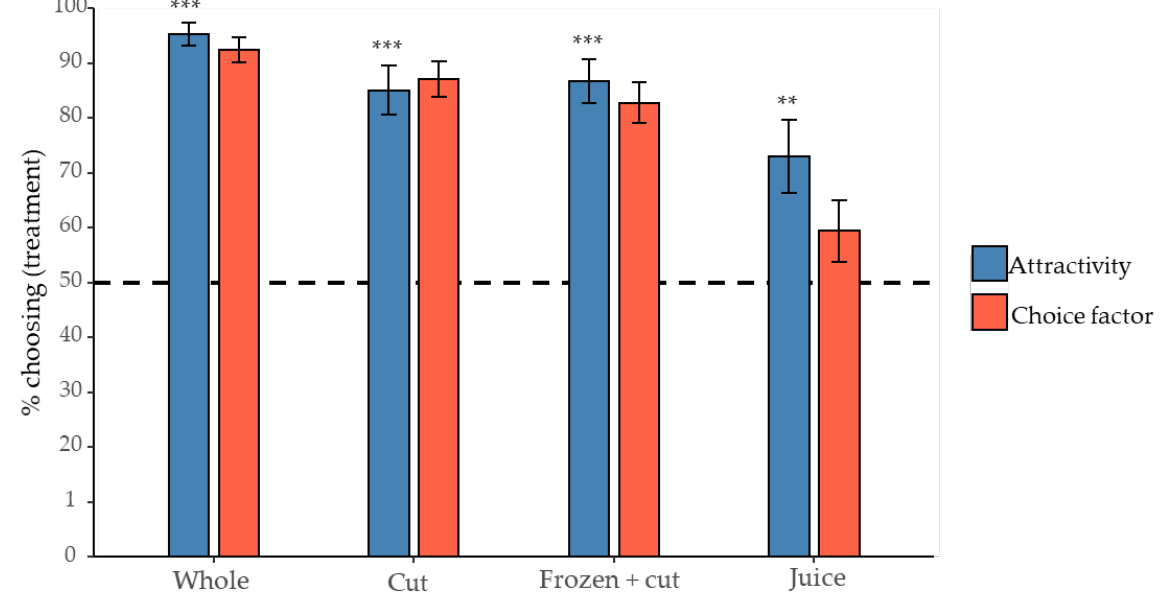
Figure 3. Results from two-choice preference tests of different blackberry conditions. Barplots in blue show the attractivity (=the proportion of flies that chose the treatment vs. the control side) of the blackberry condition. Attractivity was tested against a 50:50 distribution, shown as a horizontal dotted line (binomial GLMM, FDR corrected posthoc tests, mean ± SE, **: p < 0.01, ***: p < 0.001). Barplots in red depict the choice factor (=the proportion of flies that made a choice (choosing either the treatment or control container) vs. those that made no choice (remaining in the middle container)).